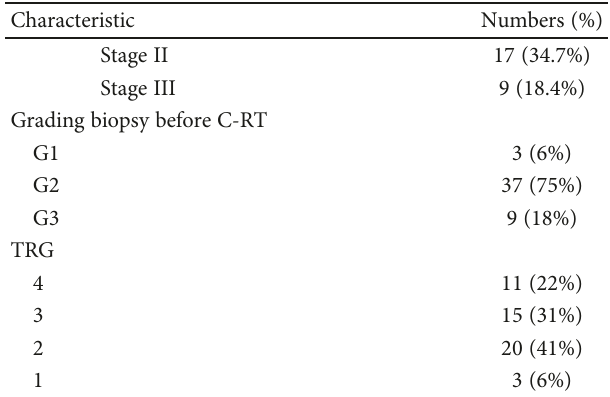
Table 1: Characteristics of